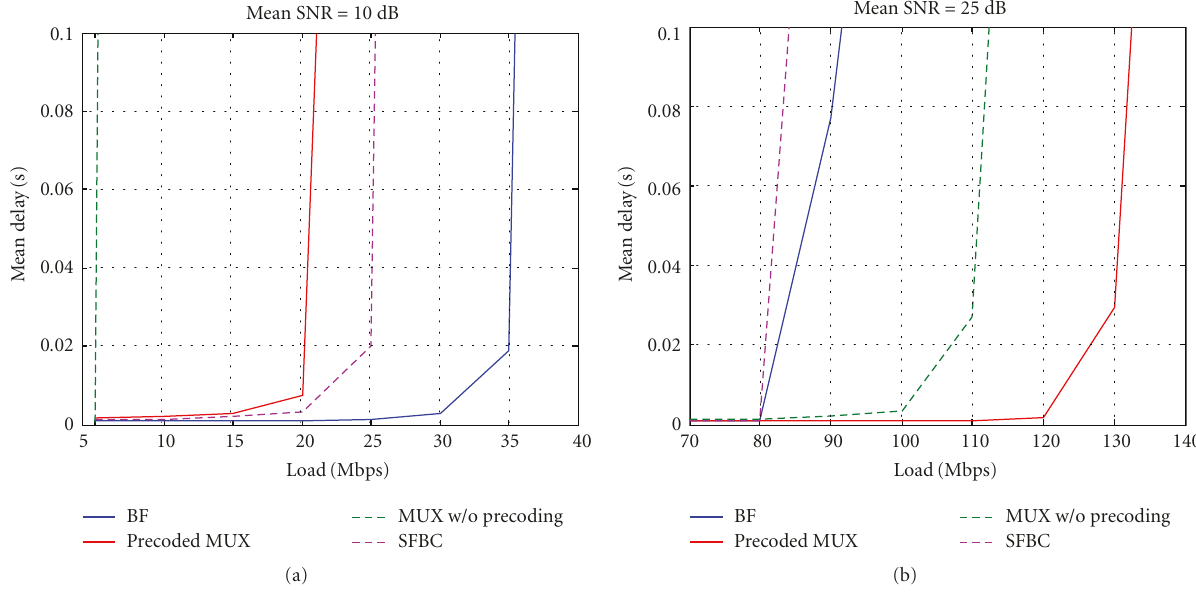
Figure 11: Mean transmission delay for di ff erent MIMO schemes when using adaptive modulation subject to restriction BER T = 10 − 3 in a pedestrian channel ( v = 3km/h, ρ = 0 . 3) with di ff erent average